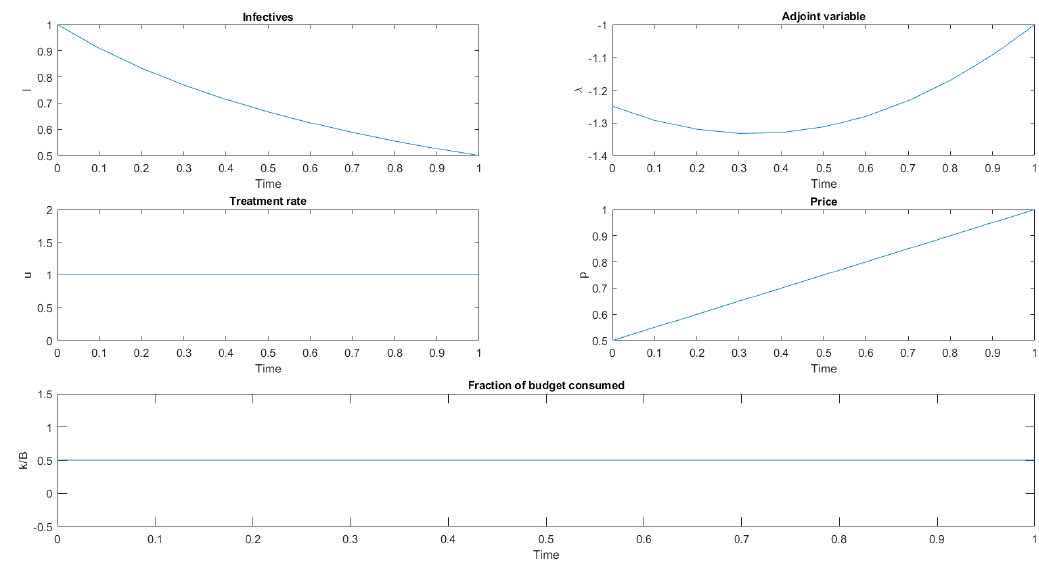
Figure 3. Cooperative solution. Blow-up cost. B =